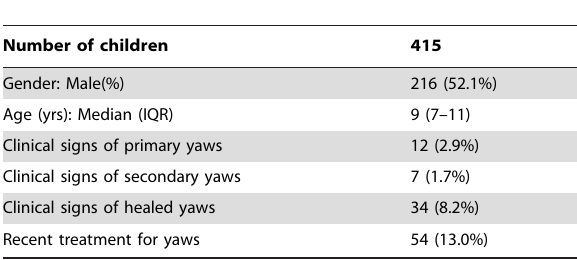
Table 1. Participant characteristics.